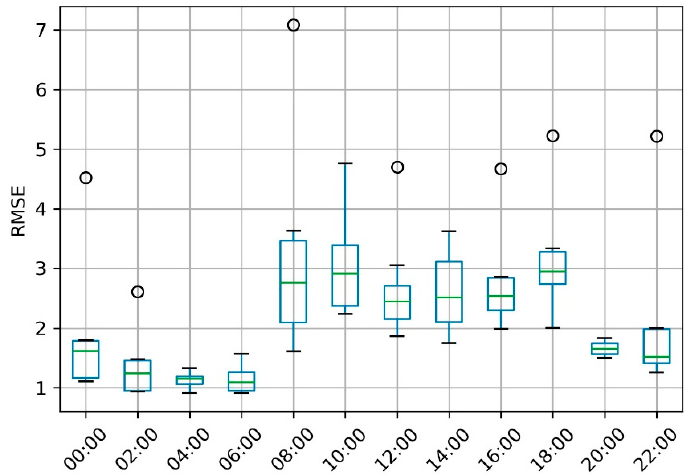
Figure 14. The results of eight split groups overlapping 12 time nodes in the predicted